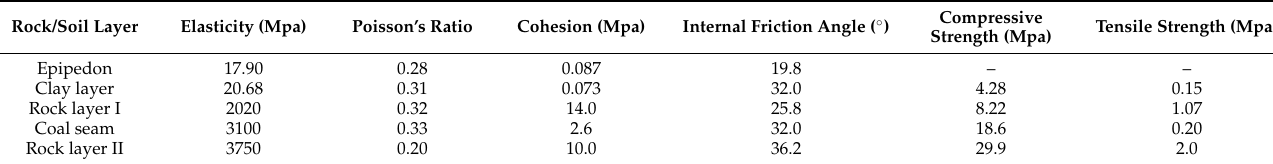
Table 2. Numerical model parameter.